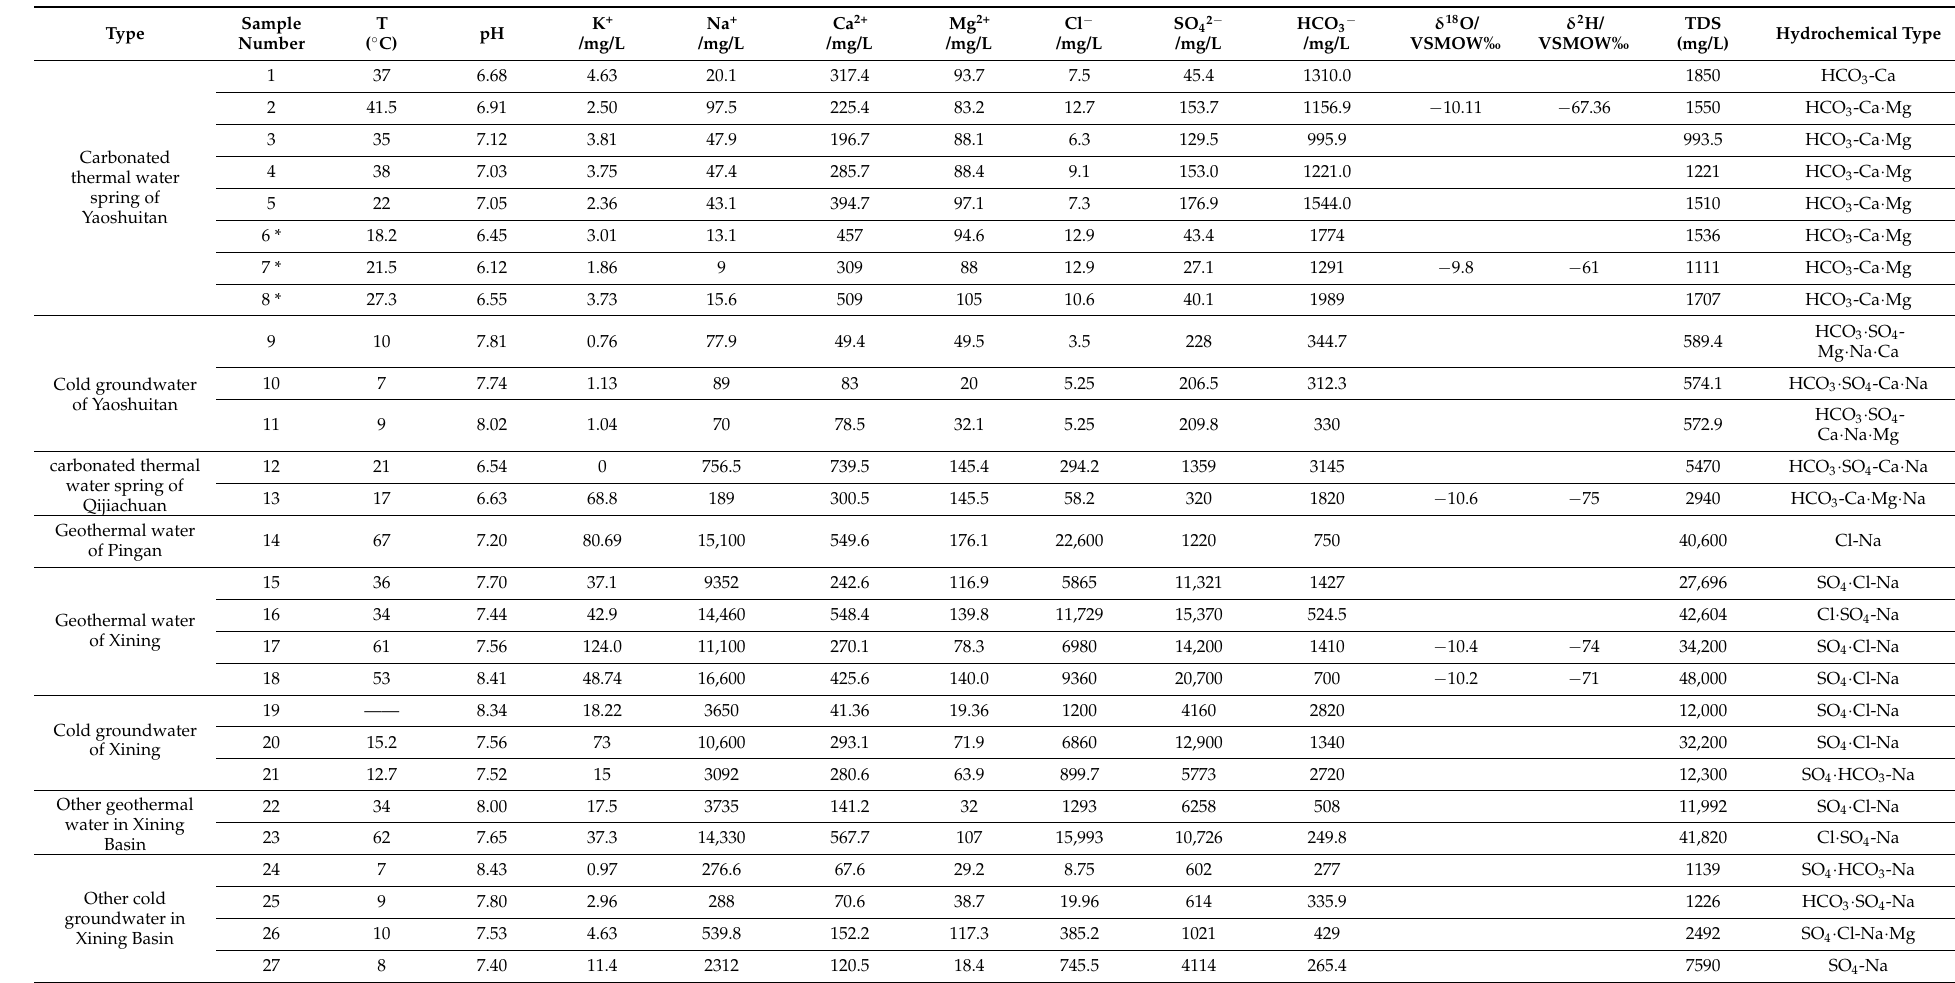
Table 1. Test results of main chemical components of carbonated thermal water springs, geothermal water, and groundwater in Xining